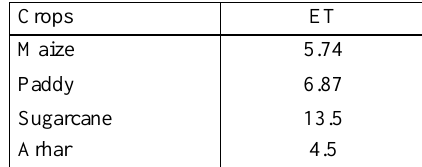
Table 2. ET values estimated by Cropwat